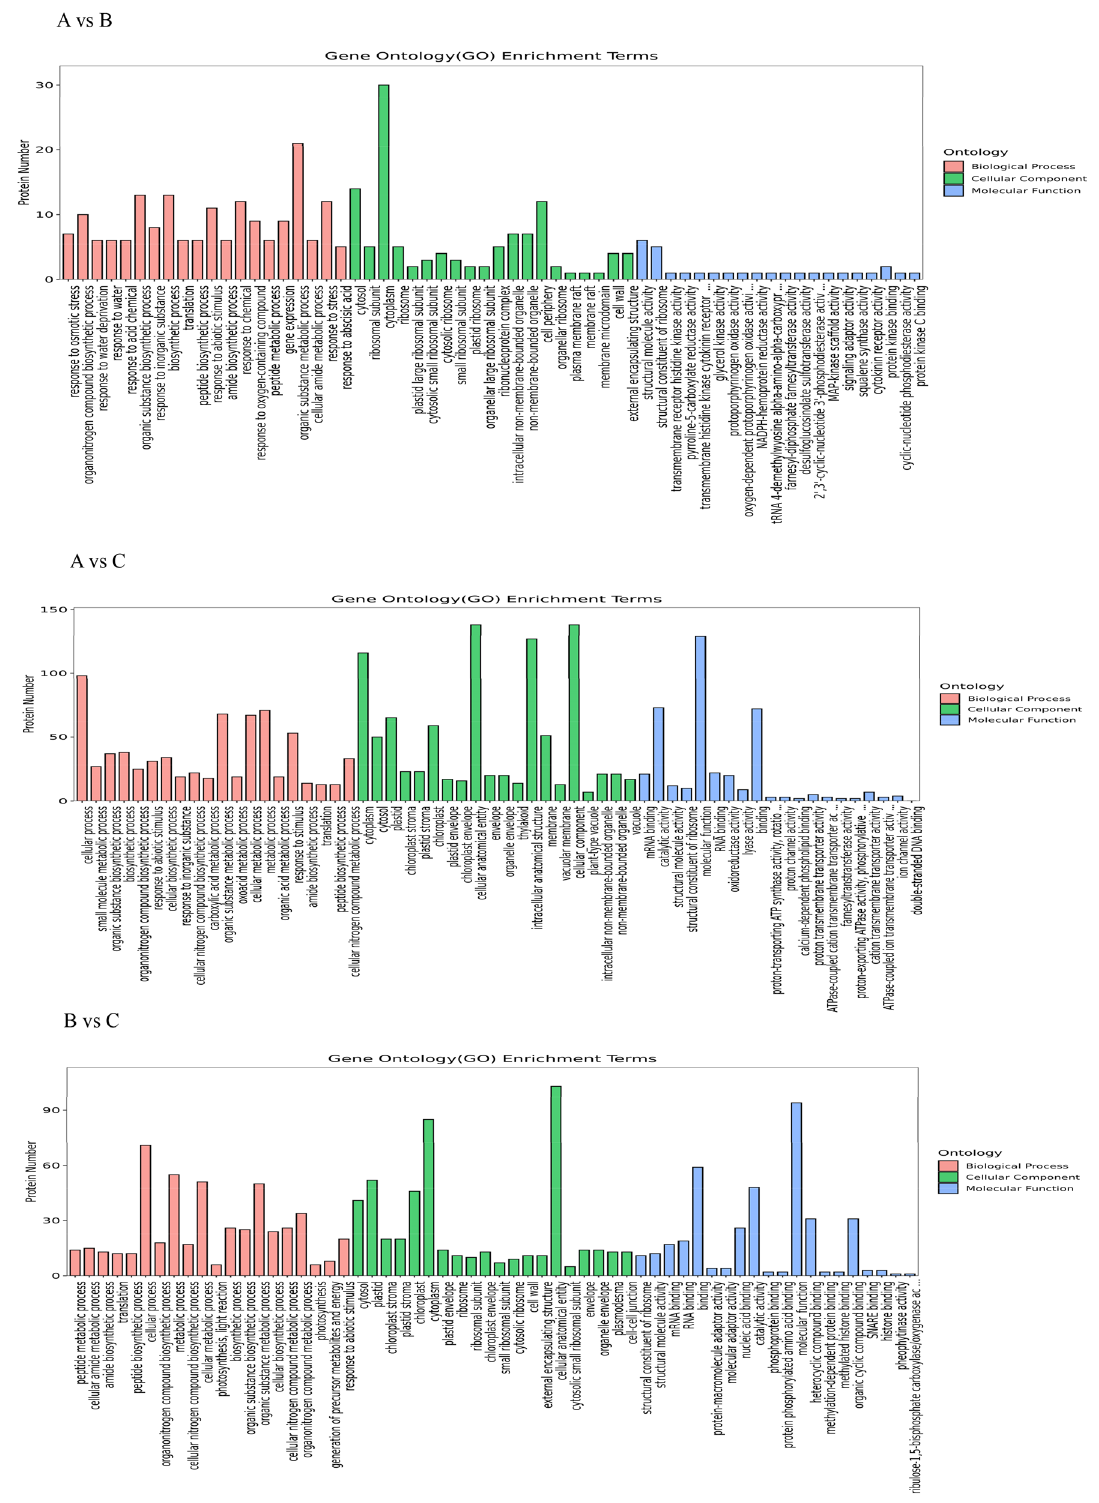
Figure 5. Gene Ontology (GO) annotation of differentially expressed proteins under the salt stress. Note : Enrichment results for the three categories are shown in the figure, with up to 20 items for